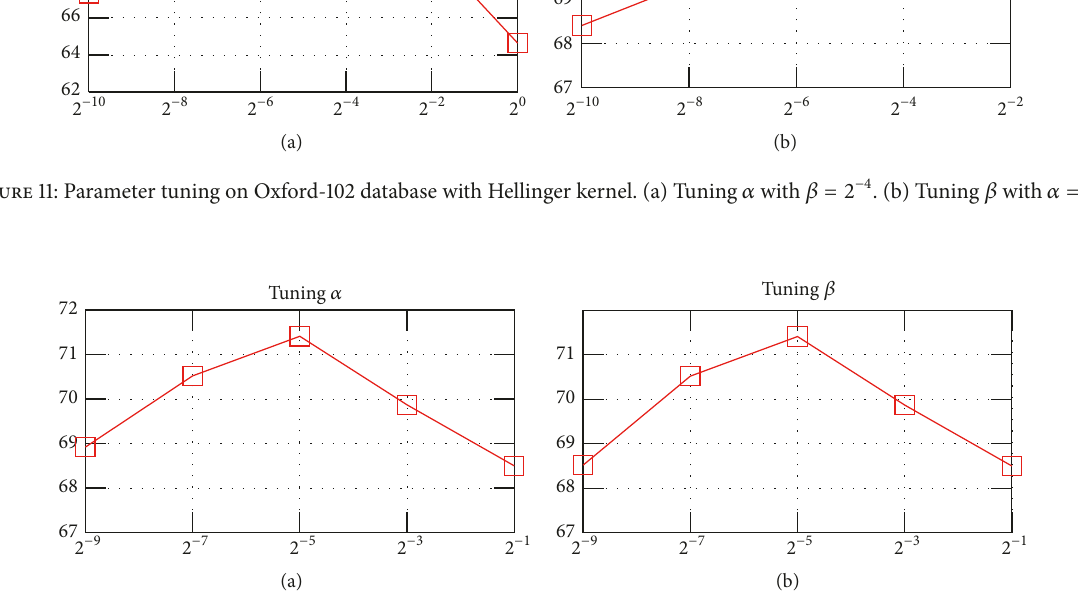
Figure 12: Parameter tuning on Oxford-102 database with polynomial kernel. (a) Tuning 𝛼 with 𝛽 = 2 −5 . (b) Tuning 𝛽 with 𝛼 = 2 −5